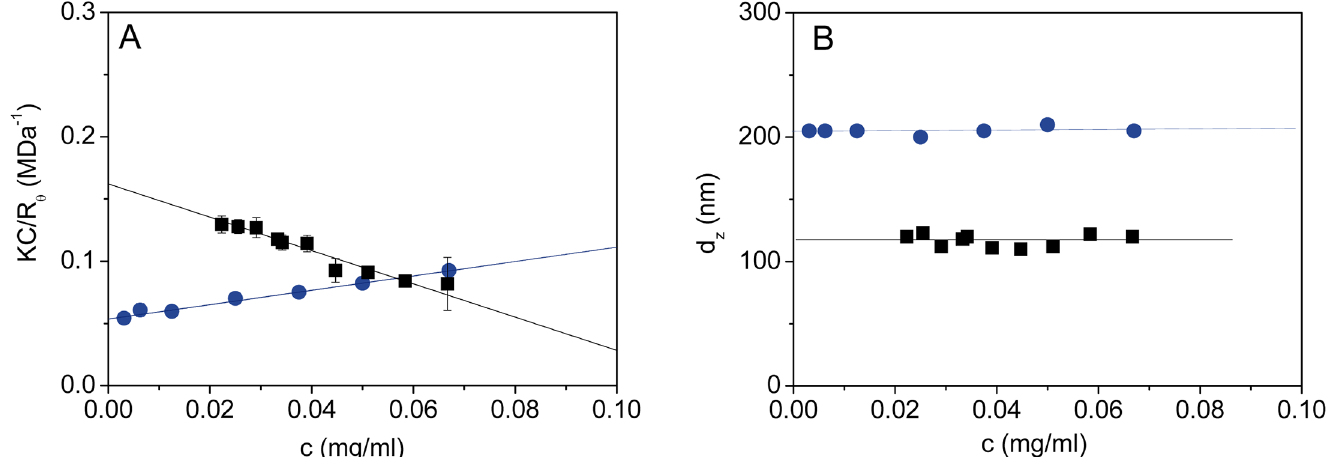
Fig 5. Experimental results obtained from Static Light Scattering experiments. (A) Debye plot of HPV16 VLPs from SLS measurements at T = 298 K for determination of the VLPs molecular weight and the second virial coefficient: ( ∎ , black) 0 hours (R 2 = 0.9735) and ( ● , blue) 48 hours (R 2 = 0.9806). The error bars indicate the standard deviation obtained from at least 15 scans. (B) Z-average size, d z , obtained from DLS cumulant analysis during SLS measurements for each concentration. The standard deviation obtained for d z is less than